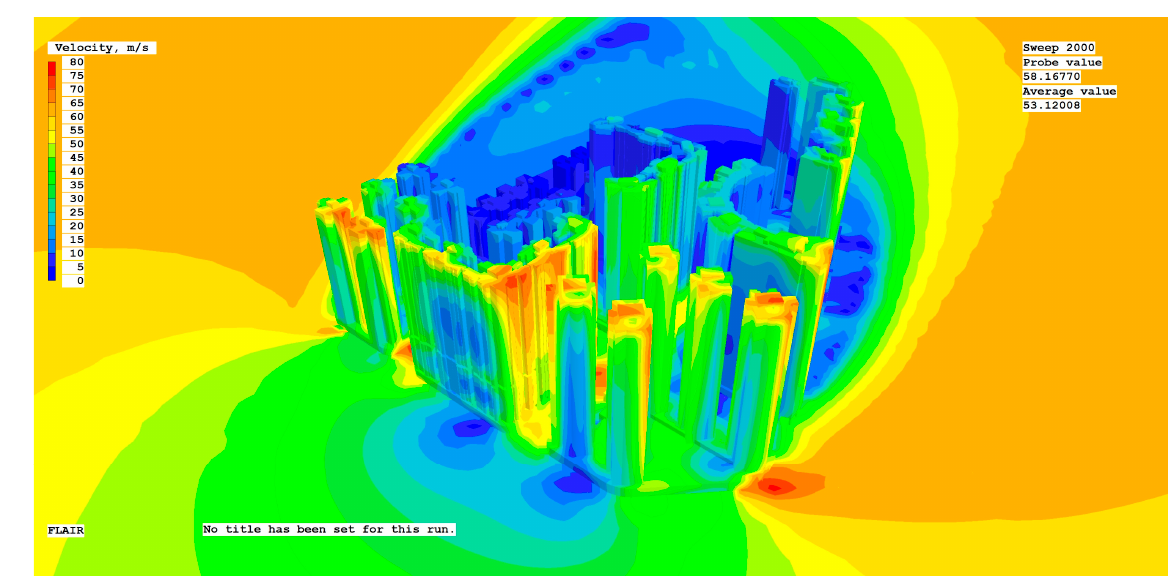
Figure A12. The La Baie du Noble looks west.